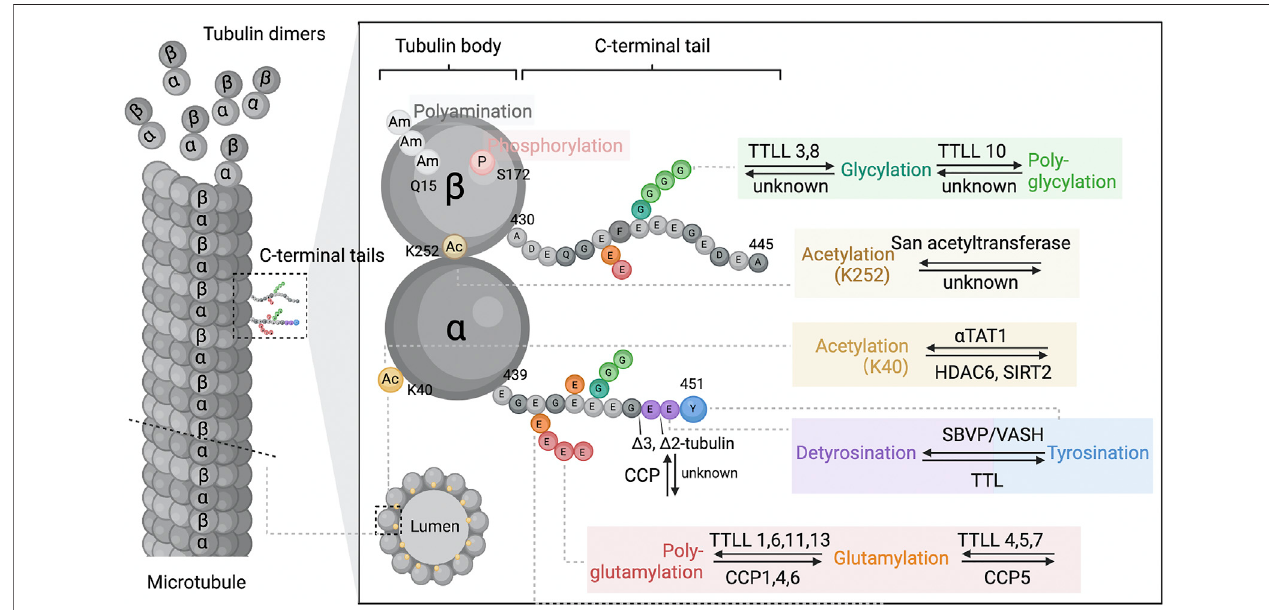
FIGURE 1| Microtubule and tubulin post-translational modi fi cations. Microtubules dynamically assemble from head-to-tail arraysof αβ -tubulin dimers. The tubulin isglobularandhighlyconservedproteinthatformsa “ tubulinbody ” .ThetubulinC-terminalaminoacidtailsareunstructuredsegmentsprotrudingfromthesurfaceofthe ordered tubulin body and may regulate microtubule intrinsic properties and the binding behaviour of microtubule associated proteins. Tubulin post-translational modi fi cationsoccureitheratspeci fi edsitesofthetubulinbody(Ac,acetylation;P,phosphorylation;Am,polyamination),orwithintheC-terminaltails(detyrosination anddetyrosination,glutamylation,glycylation, Δ 2-tubulinand Δ 3-tubulinprodecedbyglutamateresidueremovals).Thesemodi fi cationsareoftendynamicreversibleand catalysed by a range of enzymes from multiple families. During the process, the functional properties of microtubules are changed by single residue alternations (acetylation, phosphorylation, detyrosination) or modulating the non-binary signals by elongation of the side chains (polyamination, polyglutamylation, polyglycylation). Abbreviations:TTLL,tubulin – tyrosineligase-likefamily; α TAT1, a -tubulinN-acetyltransferase1;HDAC,tubulin-lysinedeacetylase;SIRT,sirtuin;SVBP,vasohibinbinding protein; VASHs, vasohibins; TTL, tubulin-tyrosine ligase-like family; CCP, cytosolic carboxypeptidase-like protein; K40, lysine